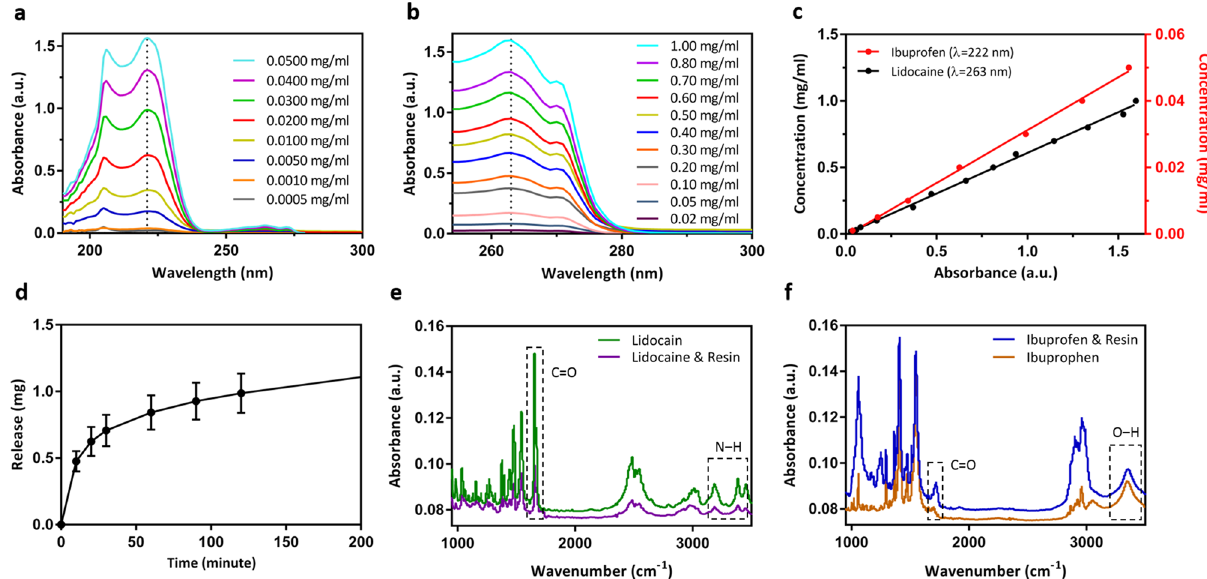
Figure 4. ( a ) UV–Vis spectroscopy of Ibuprofen for different concentrations in mg/ml, ( b ) UV–Vis spectroscopy of Lidocaine for different concentrations in mg/ml, ( c ) calibration curve of Ibuprofen and Lidocaine showing absorption amplitude in 222 nm and 263 nm for different concentrations, ( d ) release profile of Ibuprofen/resin and Lidocaine/resin microneedle patches in DPBS, each patch had one hundred microneedles, ( e ) FTIR spectroscopy of Lidocaine encapsulated in microneedle showing absorbance spectrum of lidocaine powder compared with Lidocaine/resin, ( f ) FTIR spectroscopy of ibuprofen encapsulated in microneedle showing absorbance spectrum of Ibuprofen powder compared with